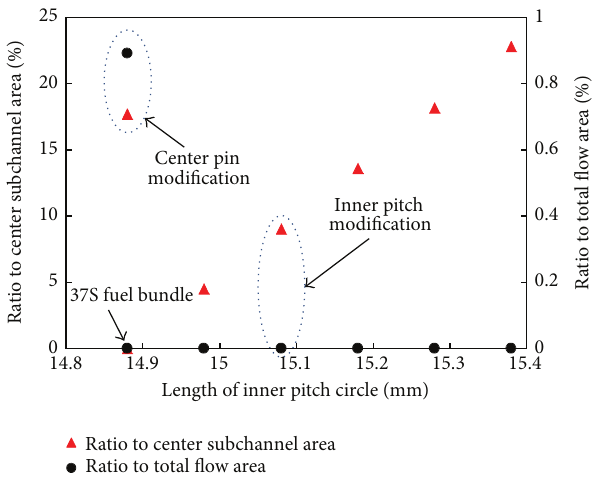
Figure 4: Variation of the inner subchannel area according to increasing inner pitch